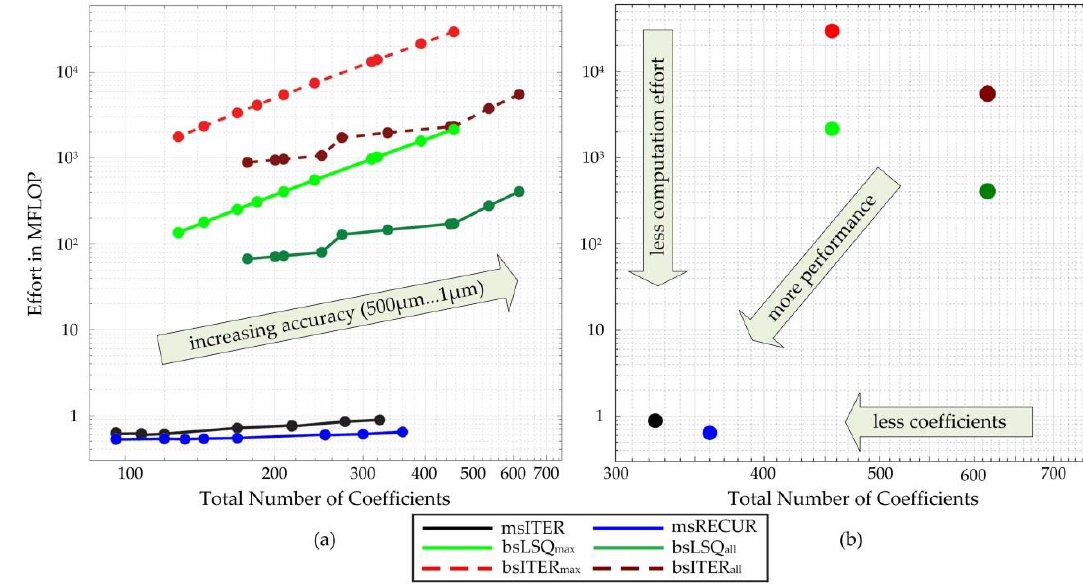
Figure 7. Comparison of the performance of the algorithms with coupled drive coordinates. ( a ) Trend of the performance as a function of the accuracy. ( b ) Performance for the relevant accuracy of 1 µm.